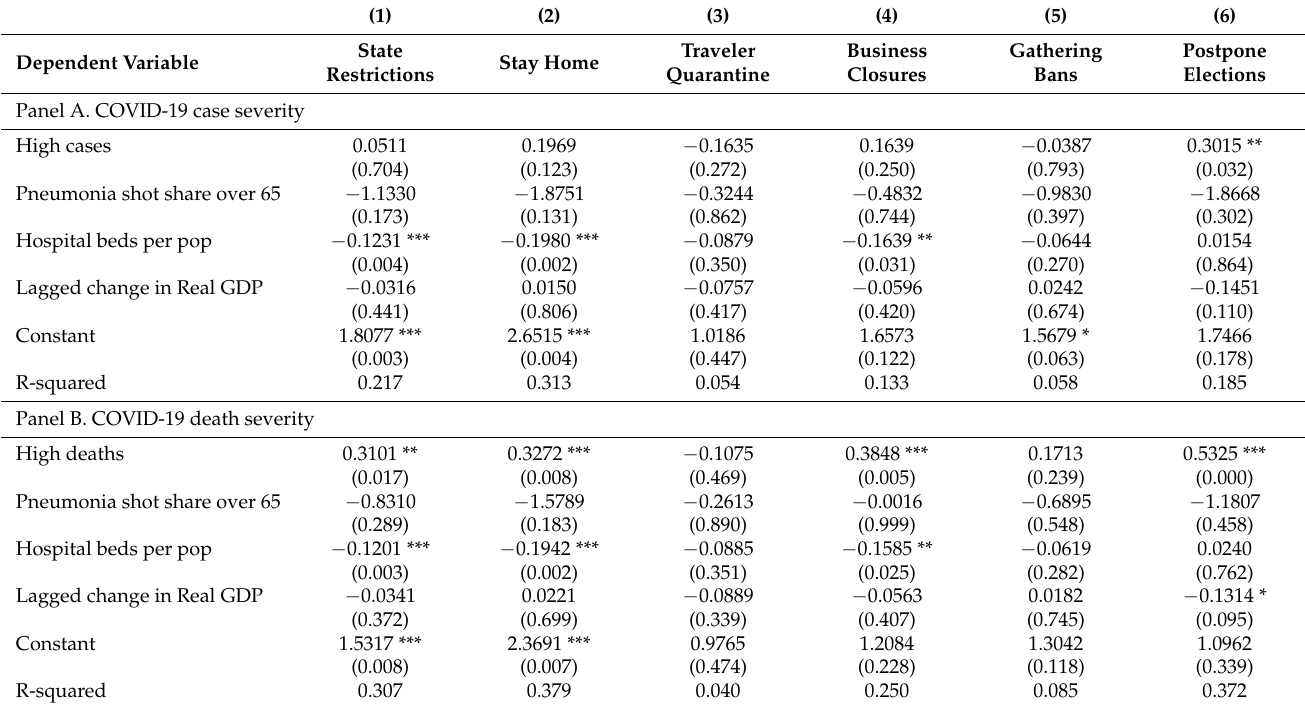
Table 2. The determinants of state policy